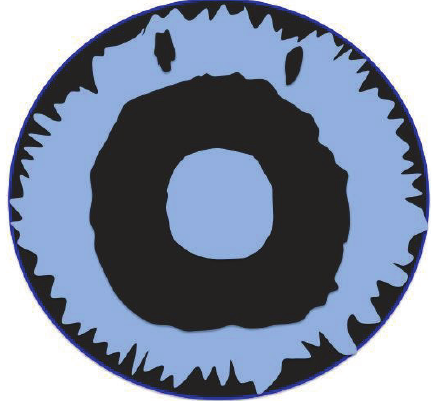
Figure 3: Target-like appearance pseudoexfoliation deposits on a natural lens with a central disc of pseudoexfoliation surrounded by a clear intermediate zone and the outermost deposits.